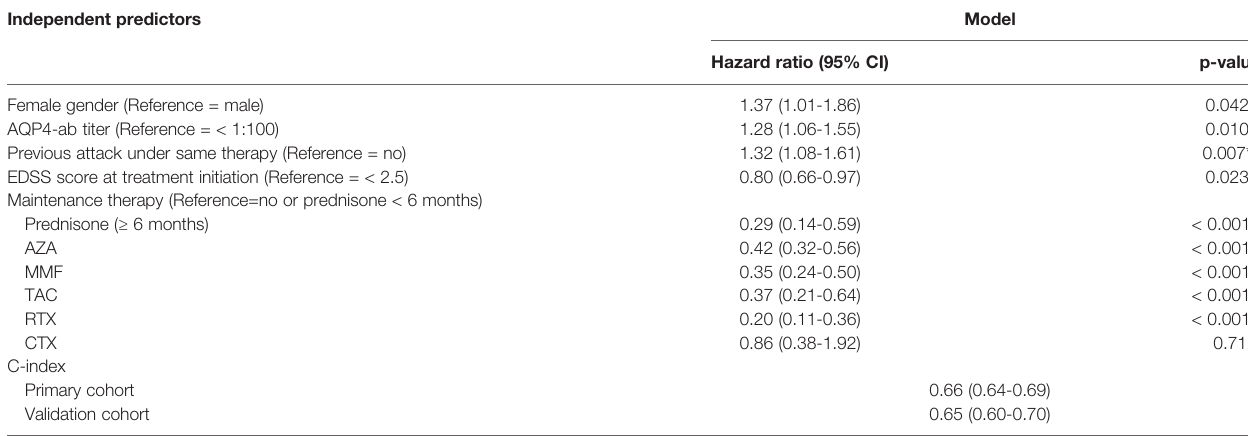
TABLE 4 | Independent predictors of recurrent relapse with multivariate Anderson and Gill